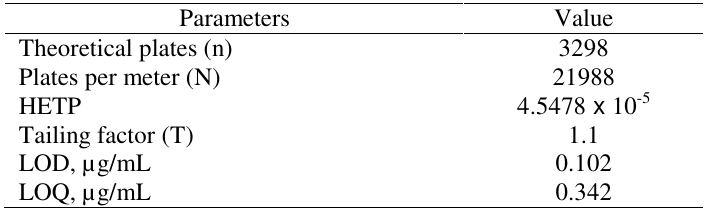
Table 5. System suitability parameters